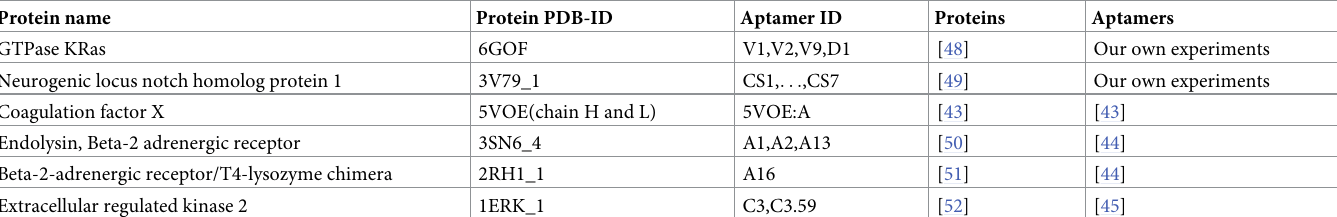
Table 2. Target proteins and aptamers obtained from PDB database, which were applied for our model. Protein